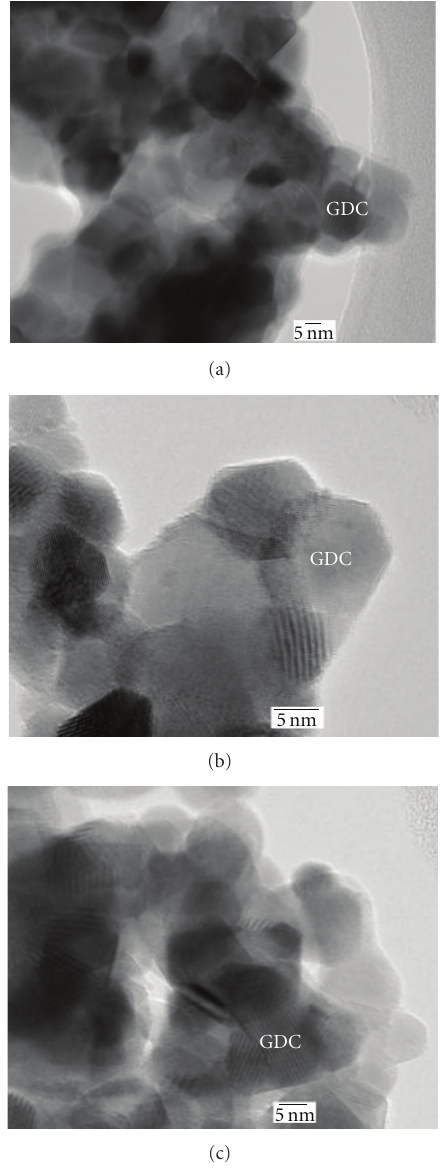
Figure 11: TEM image of the postreformed catalyst. (a) RuPd, (b) RuRh, and (c)